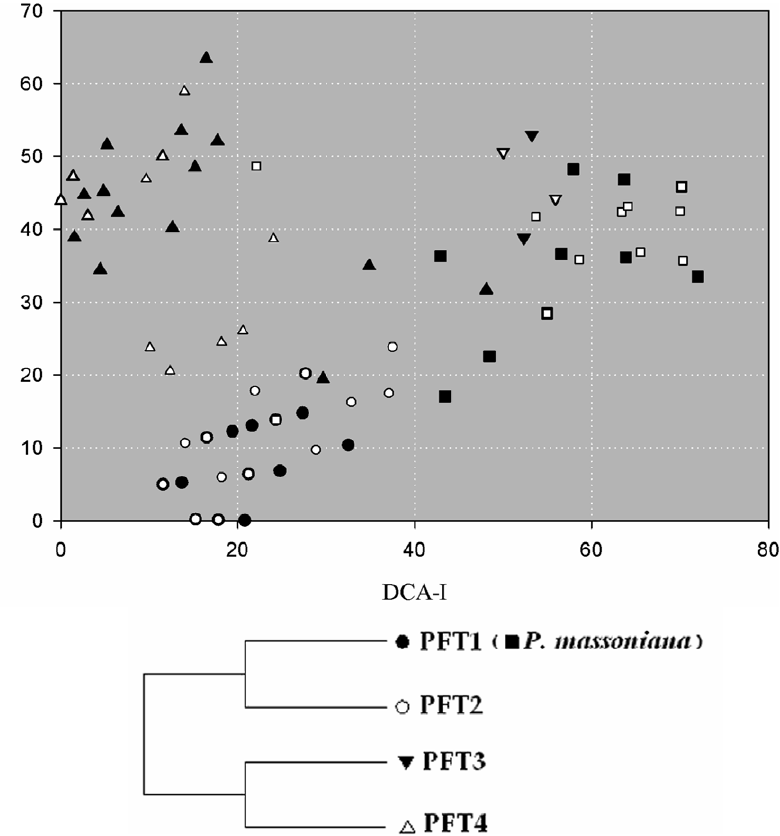
Figure 2. Detrended Correspondence Analysis (DCA) of the species 6 traits matrix. Plant functional types (top) defined by TWINSPAN (bottom) are described in Table 3. Masson pine ( P. massoniana , dark square) is close to PFT1 (dark circle) indicating they have the similar traits.